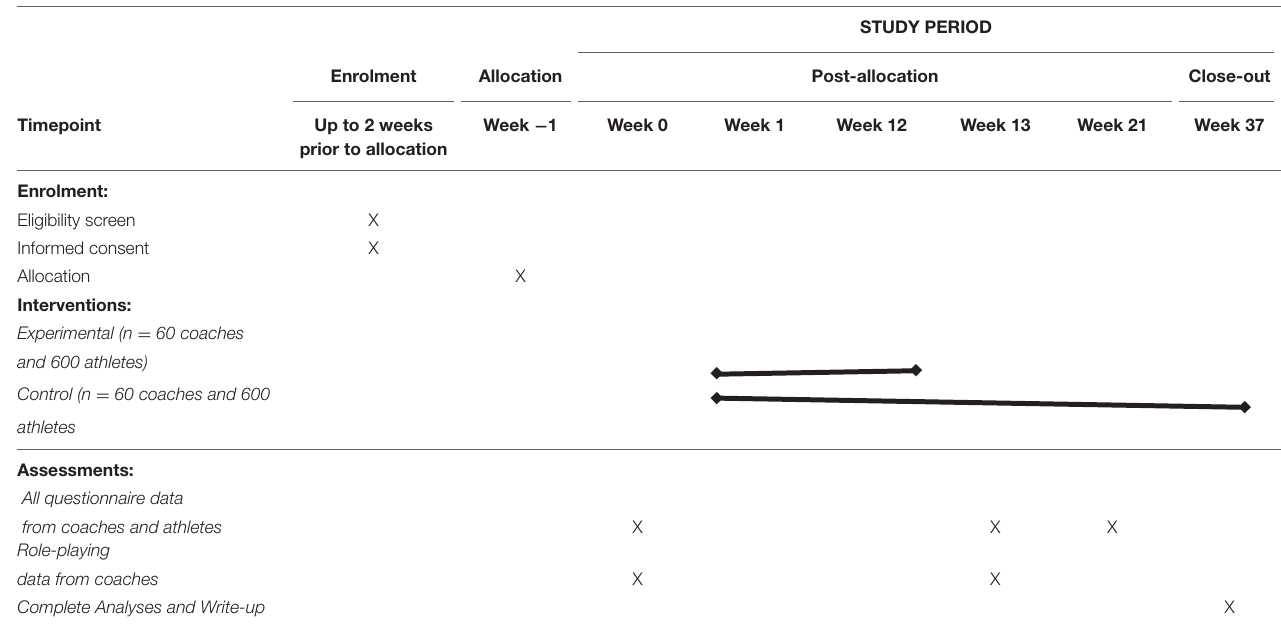
TABLE 1 | The SPIRIT schedule of enrolment, interventions, and